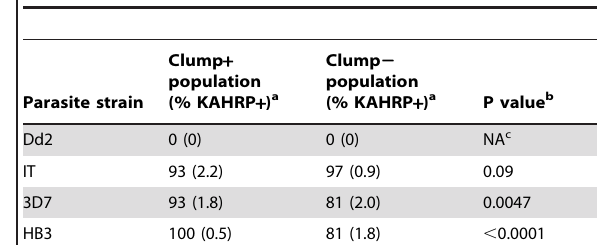
Table 2. Percentage of knob-positive infected erythrocytes in P. falciparum strains selected for clumping.